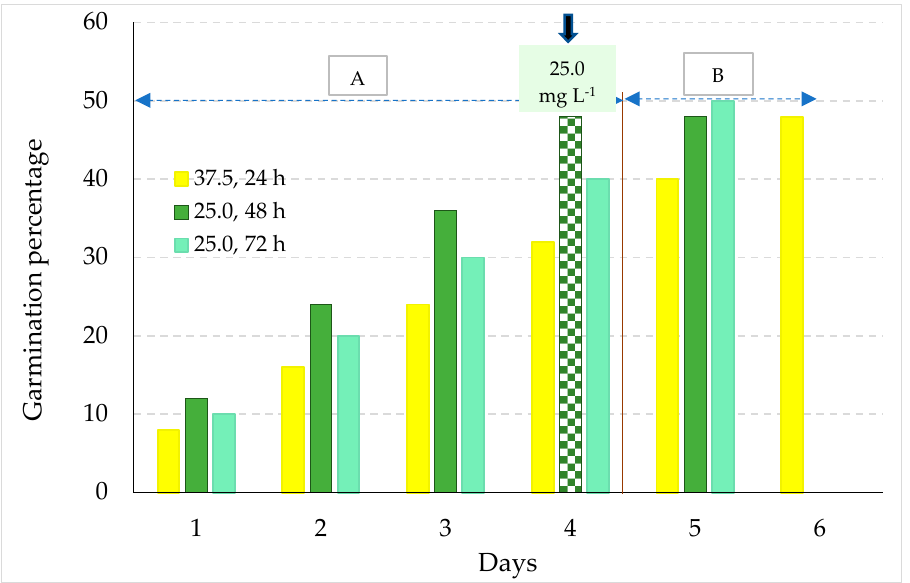
Figure 10. Responses tendency of the germination percentage to Biozyme ® TS (gibberellins) through time, displaying the best dose to reach T 50 . A: Observed tendency; B: Expected tendency.